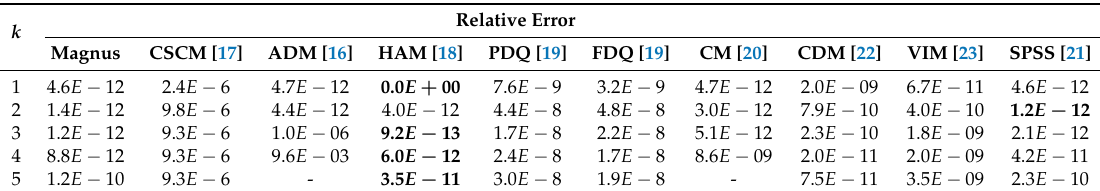
Table 8. Relative error of the first five eigenvalues for the problem in Equation (34). (Minimum relative error for each eigenvalue is in bold.)